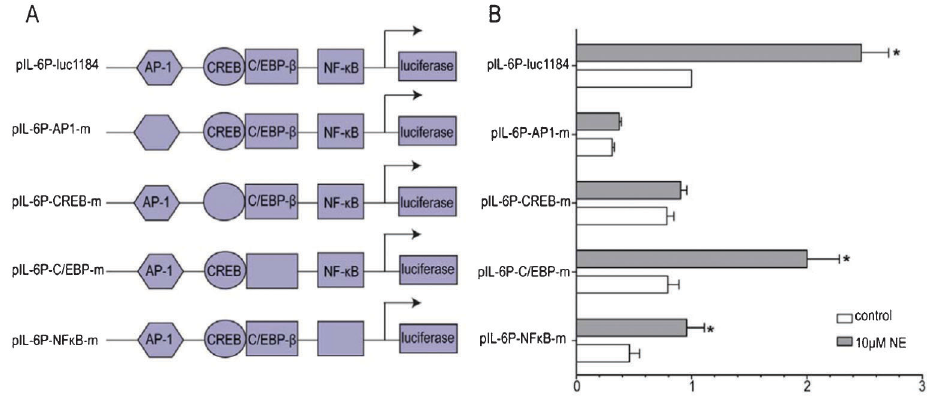
Figure 5. Site-directed mutations within the four elements affected the IL-6 promoter activity in response to 10 m M norepinephrine (NE) in GES-1 cells. A , Schematic structure of site-directed mutations within the four transcriptional factor binding sites (AP-1, CREB, C/EBP- b , and NF- k B elements) of IL-6 promoter. B , Mutational analysis of IL-6 promoter activity in response to NE. GES-1 cells were transfected with luciferase expression vectors driven by the human IL-6 promoter or variants bearing point mutations in the AP-1 (activating protein-1), CREB (cAMP-responsive element binding protein), C/EBP- b (CCAAT-enhancer binding protein- b ), and NF- k B (nuclear factor k -light-chain-enhancer of activated B cells) binding sites. Following transfection, cells were cultured for 3 h in 10 m M NE. The cells were lysed and assayed for luciferase activity. Firefly luciferase activity was normalized to co-transfected control Renilla luciferase driven by a TK-promoter and expressed as a fold change relative to untreated wild-type IL-6 promoter (pIL-6P-luc1184). Data are reported as means±SE of 3 independent experiments with triplicate measurements. *P , 0.05, compared to untreated wild-type IL- 6 promoter (pIL-6P-luc1184) by